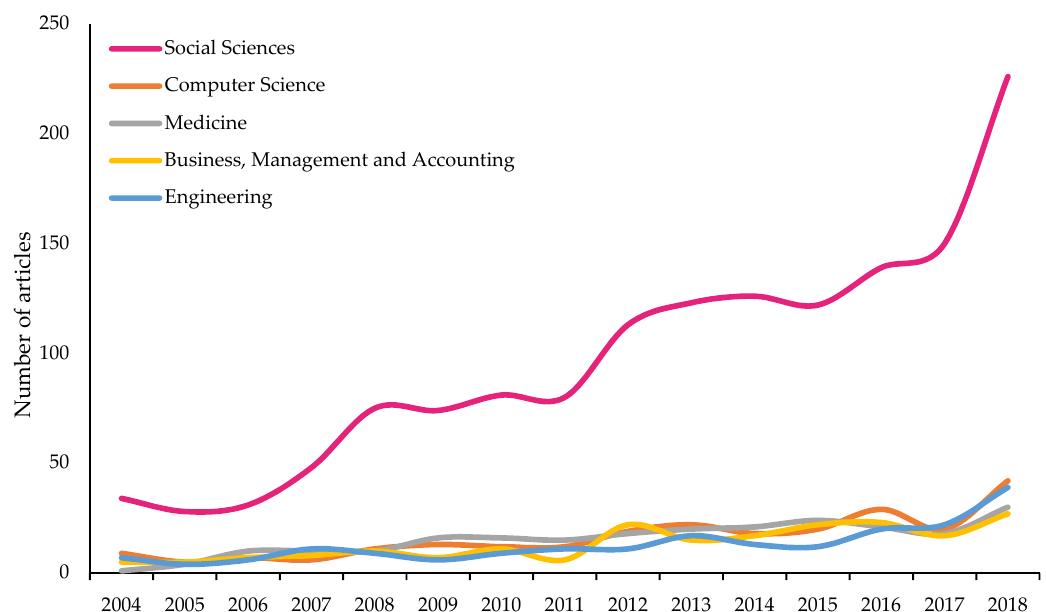
Figure 4. Growth trends of the main subject areas on the impact of the university classroom on managing the socio-educational well-being (2004–2018).